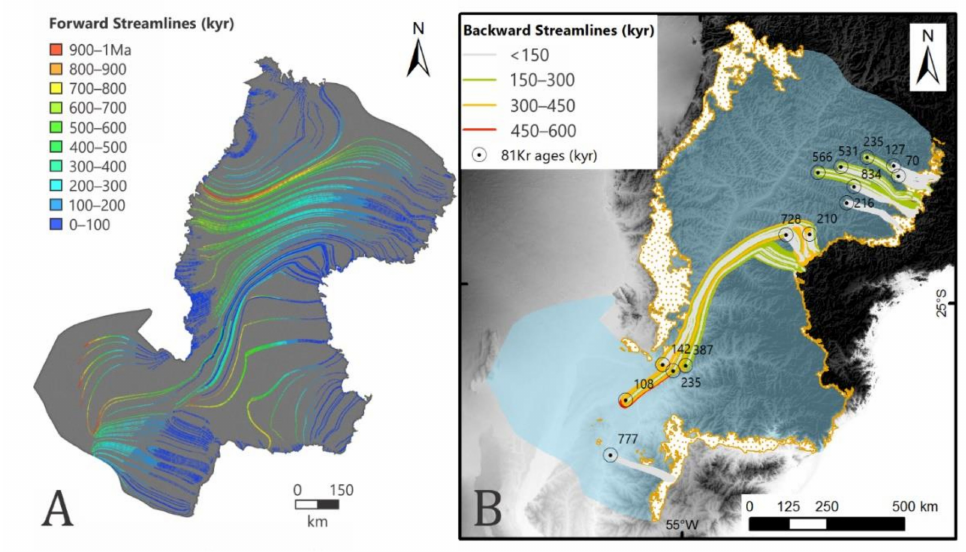
Figure 6. ( A ) Forward streamline distribution (particle tracking with travel time) by positioning seeds on the recharge areas, and ( B ) backward streamlines by positioning seeds around the dated groundwater sample locations